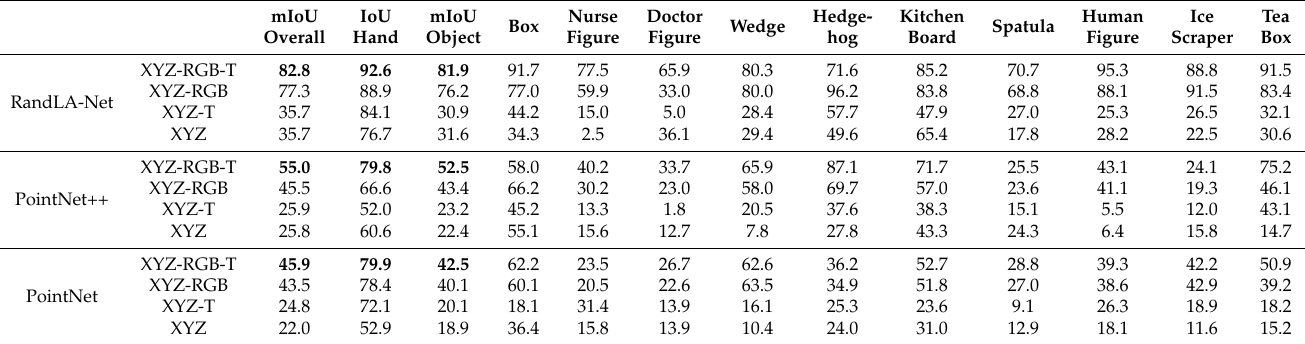
Table 3. The quantitative segmentation results on test split of the GOBO-Dataset (IoU %). Figure Figure hog Board Figure